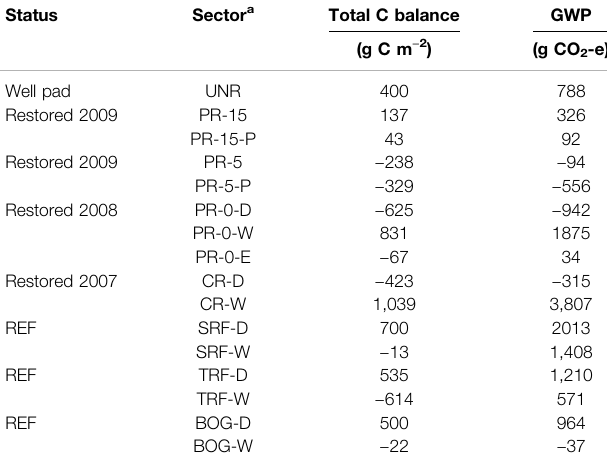
a UNR: Unrestored; CR: Complete removal of mineral soil (MS); PR-15: Partial removal MSto 15 cm aboveseasonal watertable; PR-5: Partial removalofMS to 4 – 6 cm above seasonal water table; PR-0-D/W: Partial removal of MS to surface elevation of surrounding fen reference ecosystem (uneven ground relief); PR-0-E: Partial removal of MS to near the surrounding fen reference ecosystem (even ground relief); REF-BOG: a wooded bog; REF-TRF: a treed rich fen; REF-SRF: a shrubby extreme-rich